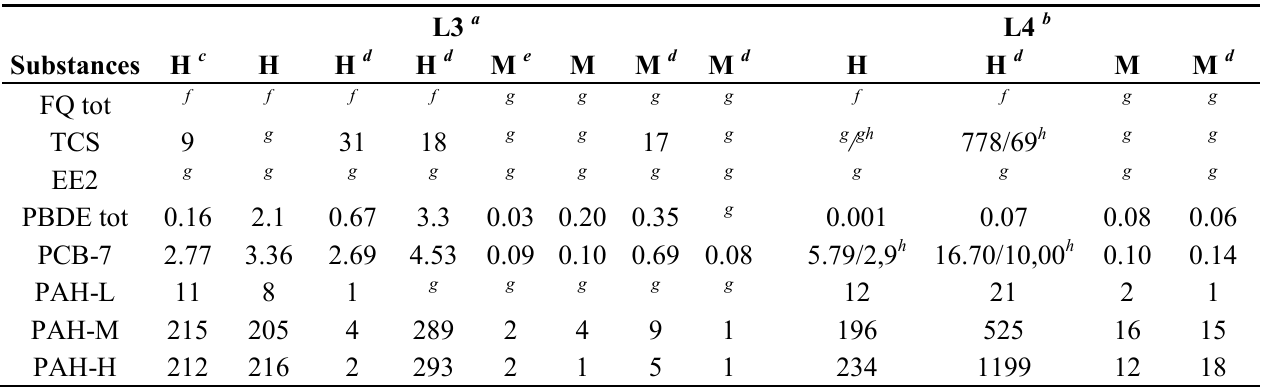
Table 2. Levels (µg kg −1 dm) of the synthetic organic substances in samples from the full-scale sites.